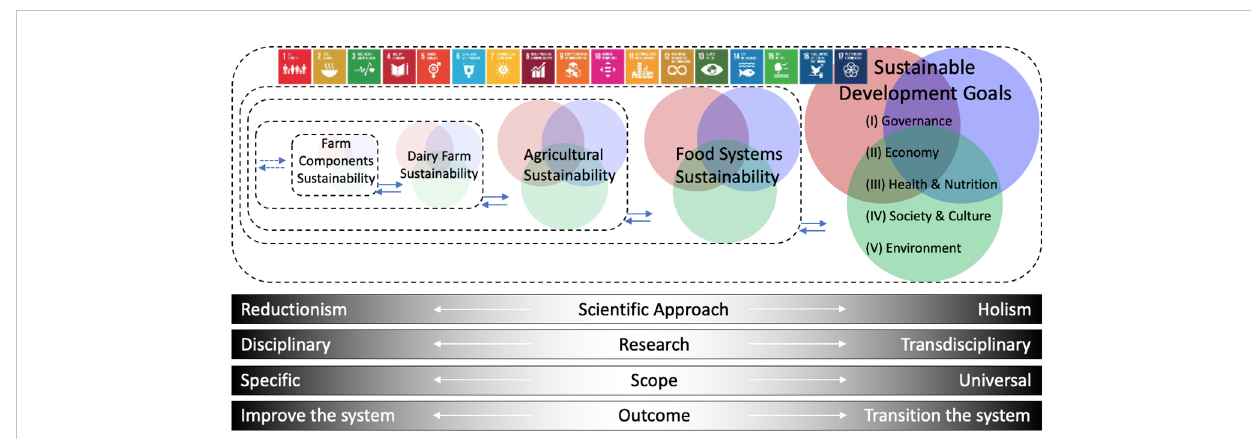
FIGURE 2 Dairy farm sustainability viewed as nested within agricultural sustainability, food systems sustainability, and the national commitment of a country to achieve the Sustainable Development Goals; The dotted arrows are meant to illustrate that basic life sciences (e.g., biochemistry and genetics) serve as the foundation for the research of biological farm components (e.g., cow and crop) whereas the basic social sciences (e.g., economic and psychology) serve as the foundation of the research in the social farm components (e.g., economic viability and a farmer ’ s decision-making process); The colored circles are meant to illustrate the three pillars of sustainability (economic, environmental and social) with varying degrees of shade to illustrate that relevant indicators within each pillar may differ across systems; The solid arrows are meant to illustrate that sustainability is not in fl uenced only by the interactions of the pillars within a system but also by the drivers of the systems within which it is nested; The fi ve roman numerals borrowed from Mottet et al. (2020) are meant to illustrate the need for added dimensions of assessment as a result of broadening the scope (boundaries) of the system; and the gray scale boxes are meant to illustrate the scienti fi c paradigms as a gradual sliding